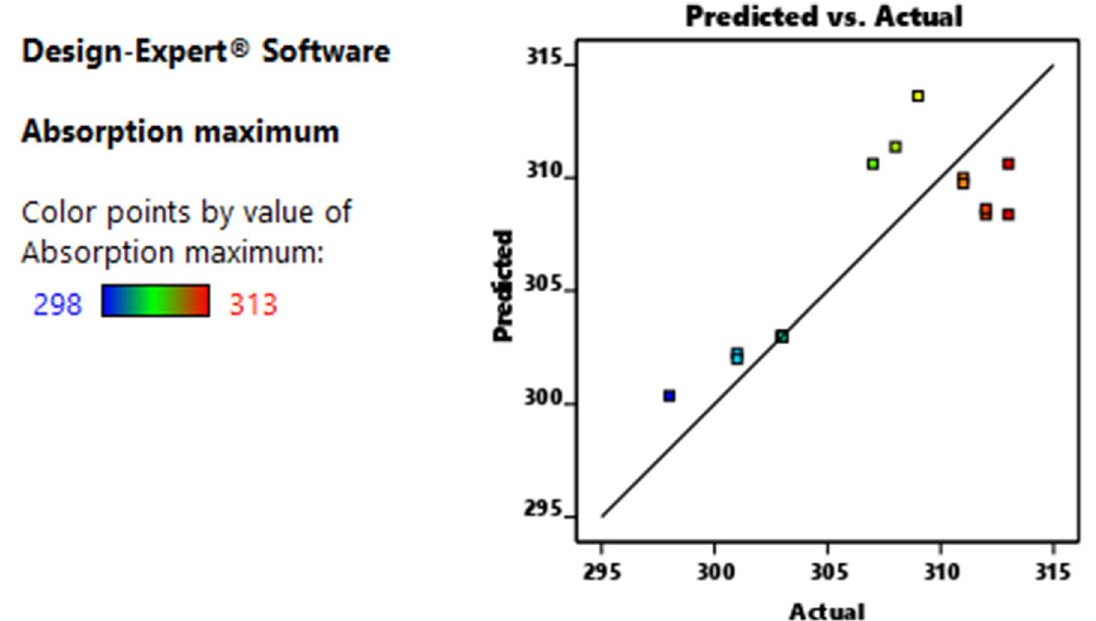
Fig. 4 Comparison of ZnO NPs wavelength absorption maximum between predicted and actual Fig. 5 The desirability ramp for the optimization of three factors (viz. Zinc acetate conc., plant extract conc. and pH) to yield best absorption maximum for ZnO